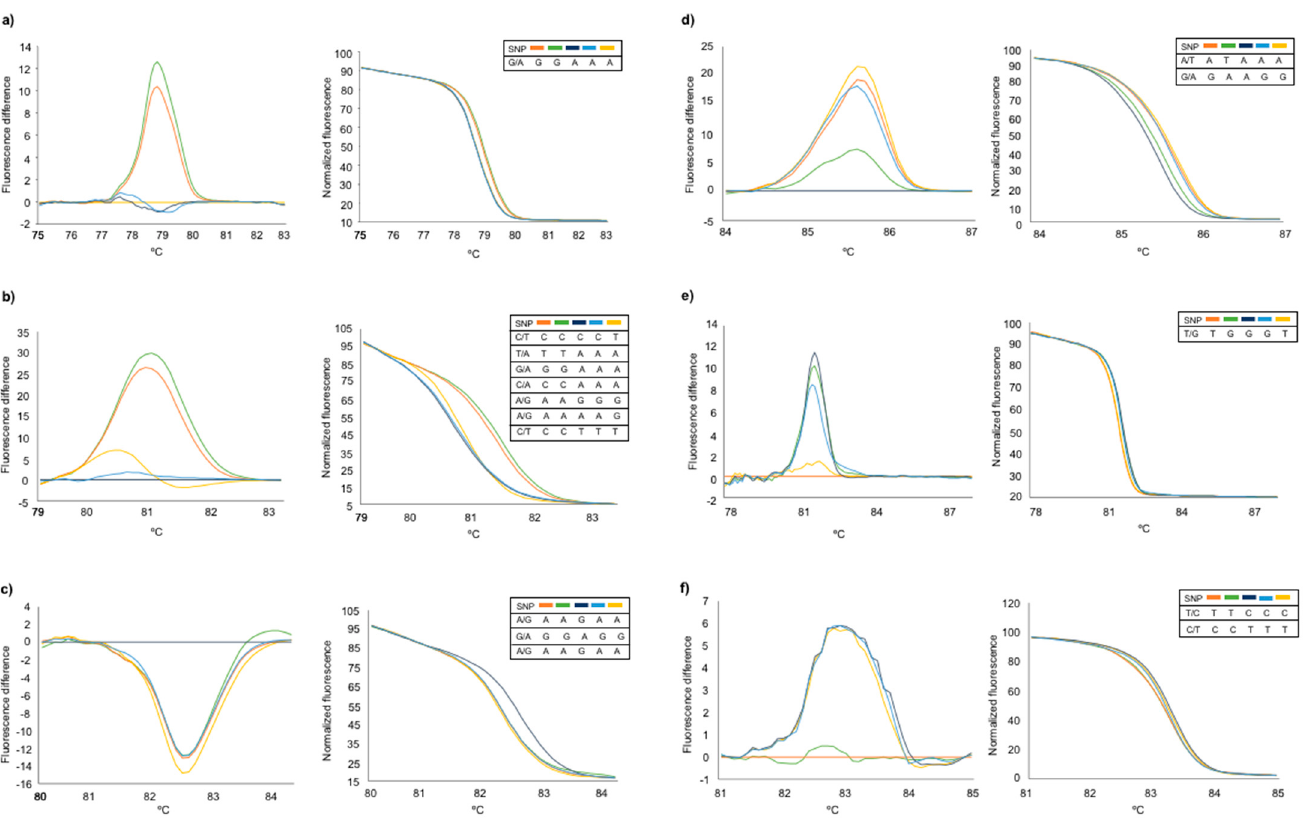
Figure 1. Sequence validation for insertion site-based polymorphisms (ISBP) markers using high-resolution melting (HRM) analysis. Normalized curves (on the right) and difference plots (on the left) are shown for 6 ISBP markers for wheat chromosome 3B, with different nucleotide variations: ( a ) marker HRM3B_273339424 — single nucleotide transition (A/G); ( b ) marker HRM3B_124761338 — five nucleotide variations, three transitions (C/T, G/A, and A/G) and two transversions (T/A and C/A); ( c ) marker HRM3B_203288704 — three nucleotide transitions (A/G, G/A, and A/G); ( d ) marker HRM3B_465802537 — two nucleotide variations, one transversion (A/T) and one transition (G/A); ( e ) marker HRM3B_609364064 — one transversion (T/G); and ( f ) marker HRM3B_331497483 — two transitions (T/C and C/T).